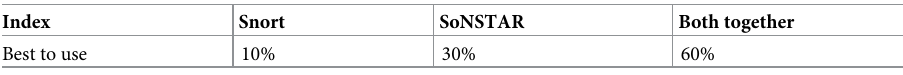
Table 8. Additional SoNSTAR evaluation (preference results).